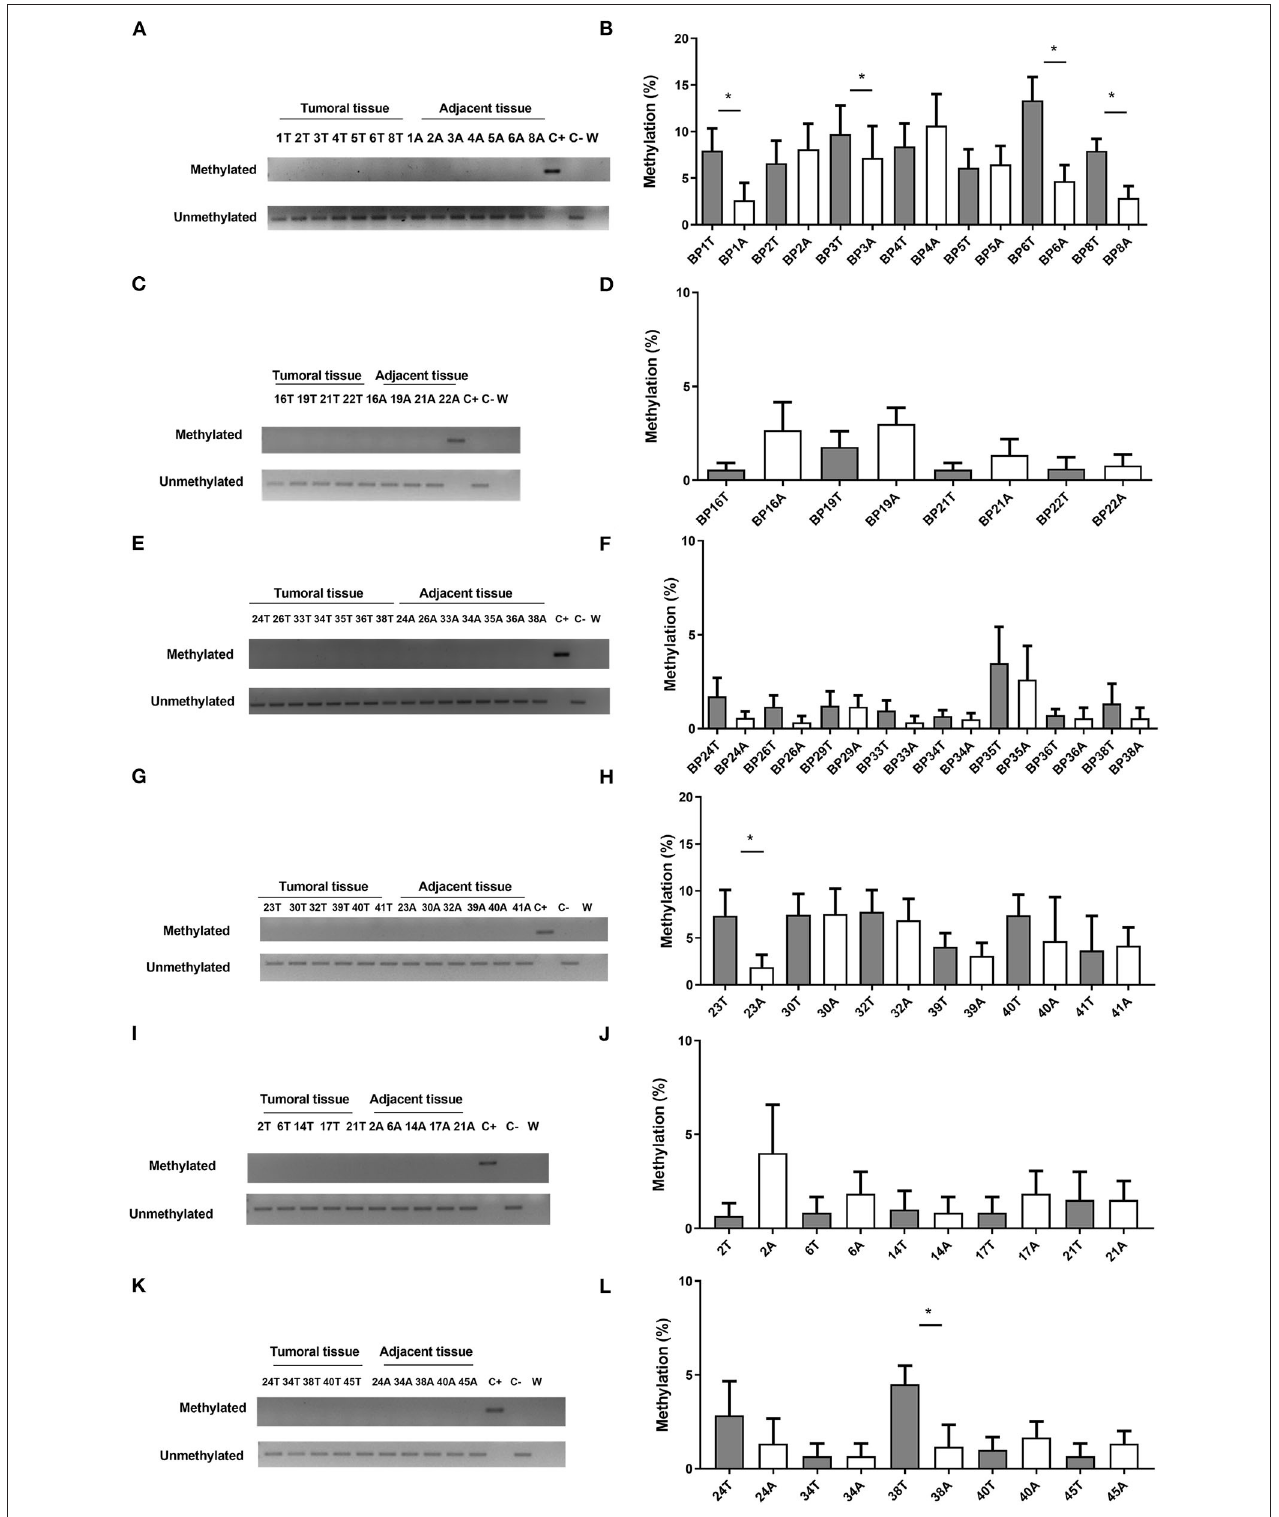
FIGURE 2 | CHFR methylation analysis of human samples, borderline (A–F) and resectable cohort (G–L) . Methylation-Specific PCR (left) and Pyrosequencing Assay (right). T (tumoral tissue) and A (Adjacent tissue). *Statistically significant differences ( p < 0.05). Columns represents mean and error bars correspond to standard